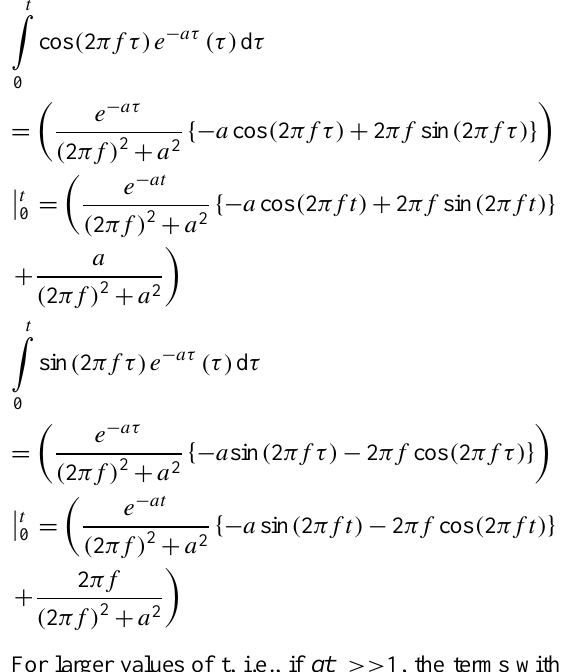
aggregate radius ( r agg ) for a given aggregate diffusivity ( D agg ) of